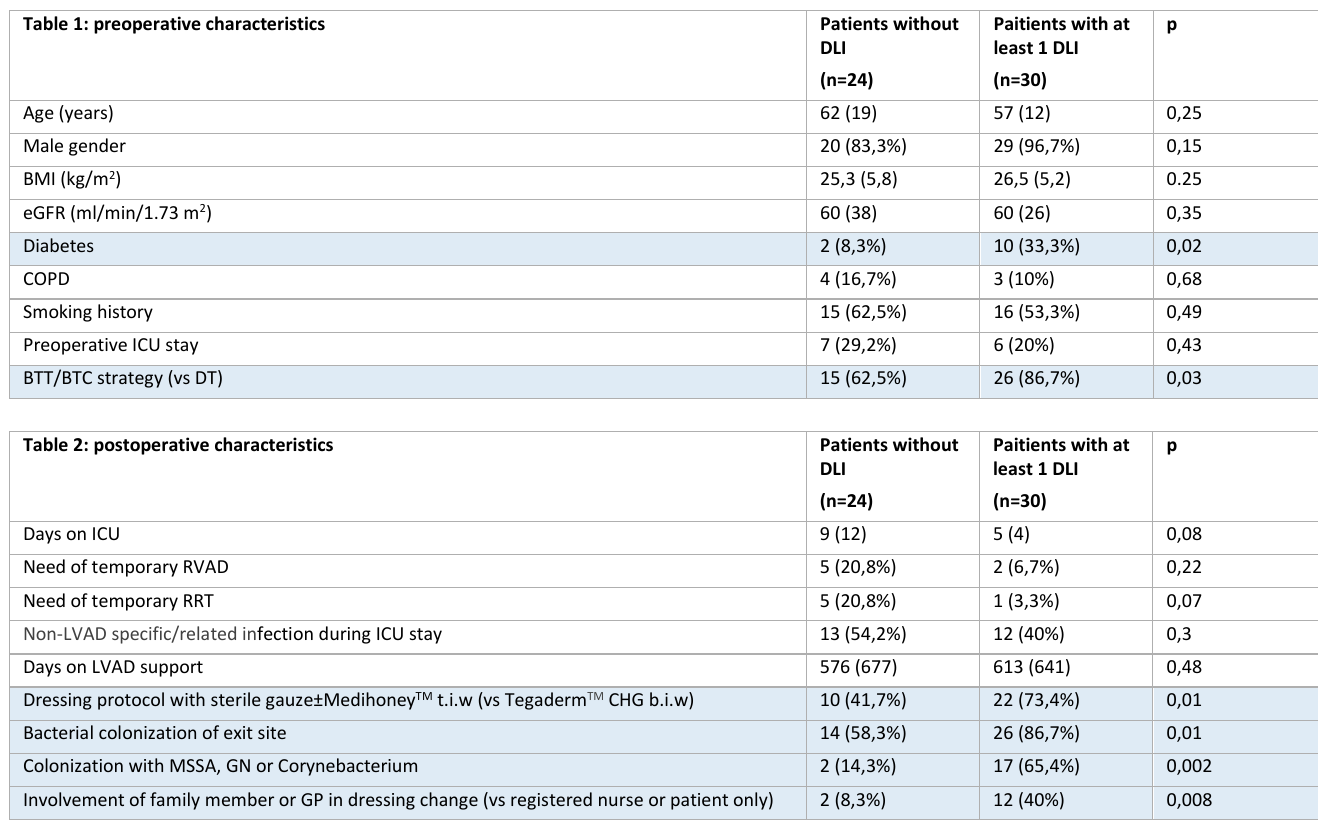
Table 2: postoperative characteristics Patients without